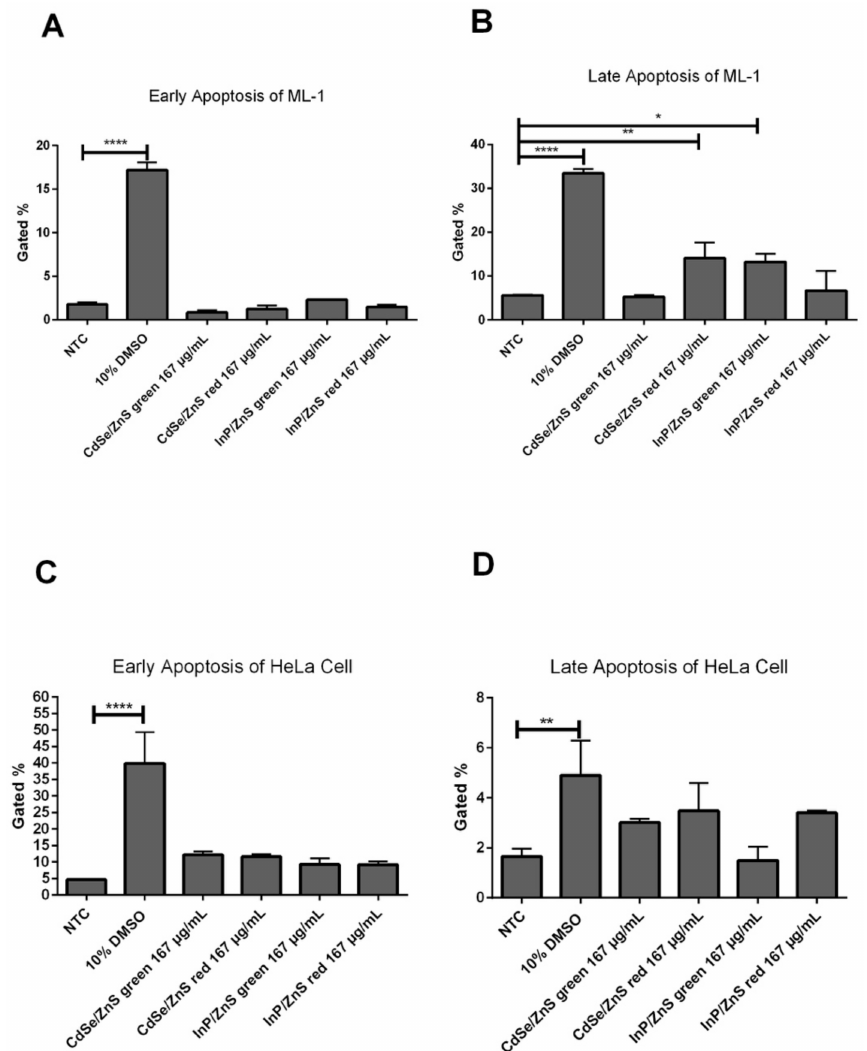
Figure 3. Levels of early and late apoptosis after 24 h treatment of green and red CdSe/ZnS and InP/ZnS QDs. ( A ) Early apoptosis levels of ML-1 cells were recorded by a flow cytometer in samples treated with 167 µ g/mL of red CdSe/ZnS and InP/ZnS QDs for 24 h. ( B ) Late apoptosis levels of ML-1 cells were recorded by a flow cytometer in samples treated with 167 µ g/mL of red CdSe/ZnS and InP/ZnS QDs for 24 h. ( C ) Early apoptosis levels of HeLa cells were recorded by a flow cytometer in samples treated with 167 µ g/mL of red CdSe/ZnS and InP/ZnS QDs for 24 h. ( D ) Late apoptosis levels of HeLa cells were recorded by a flow cytometer in samples treated with 167 µ g/mL of red CdSe/ZnS and InP/ZnS QDs for 24 h. Statistically significant results are indicated based on p -values: * = p < 0.05, ** = p < 0.01, **** = p <